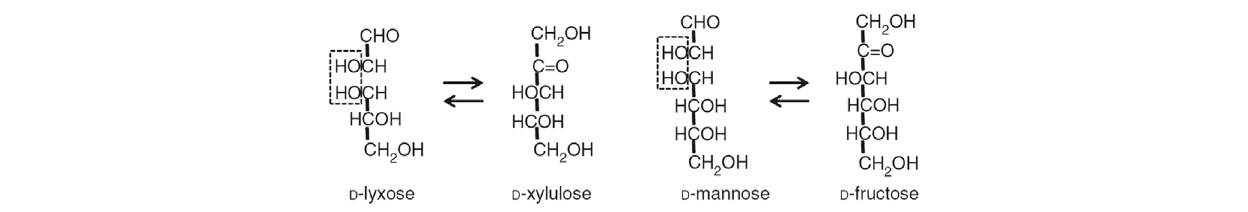
Frontiers in Bioengineering and Biotechnology |